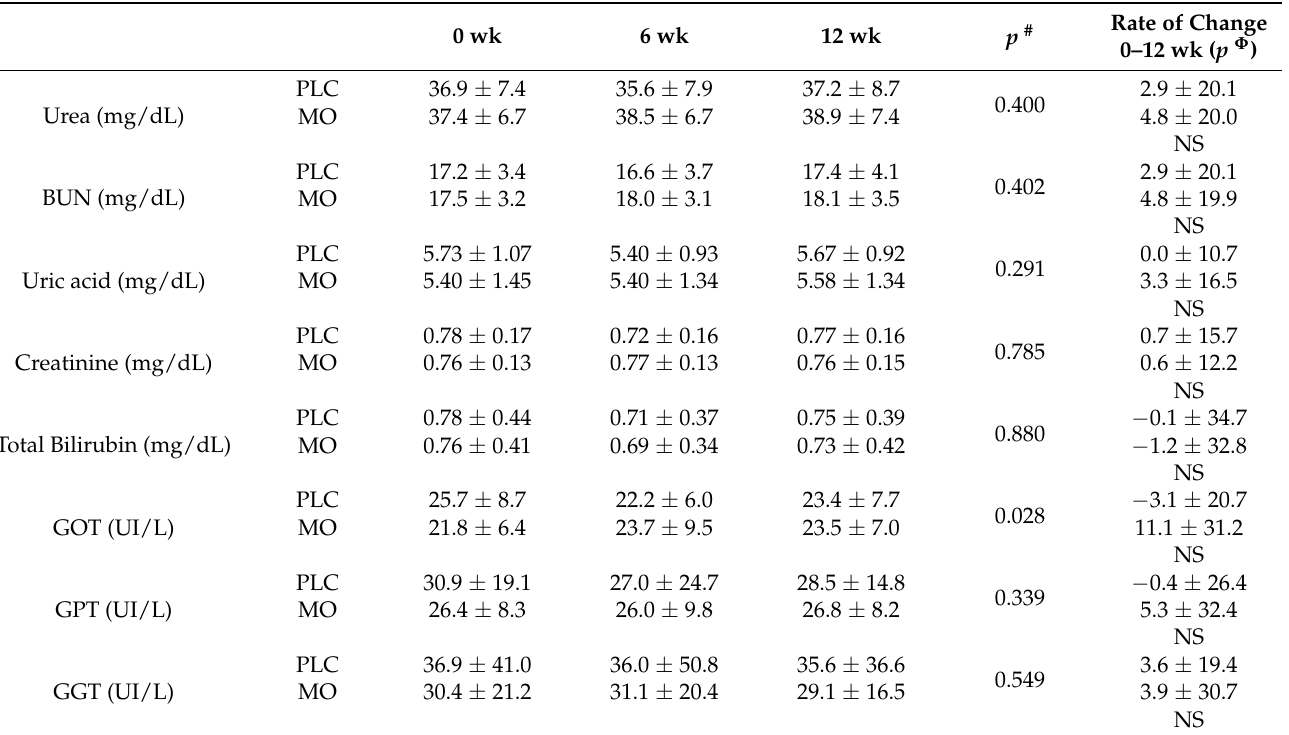
Table 6. Renal and hepatic function parameters in serum samples of patients with prediabetes of the PLC and MO groups during the